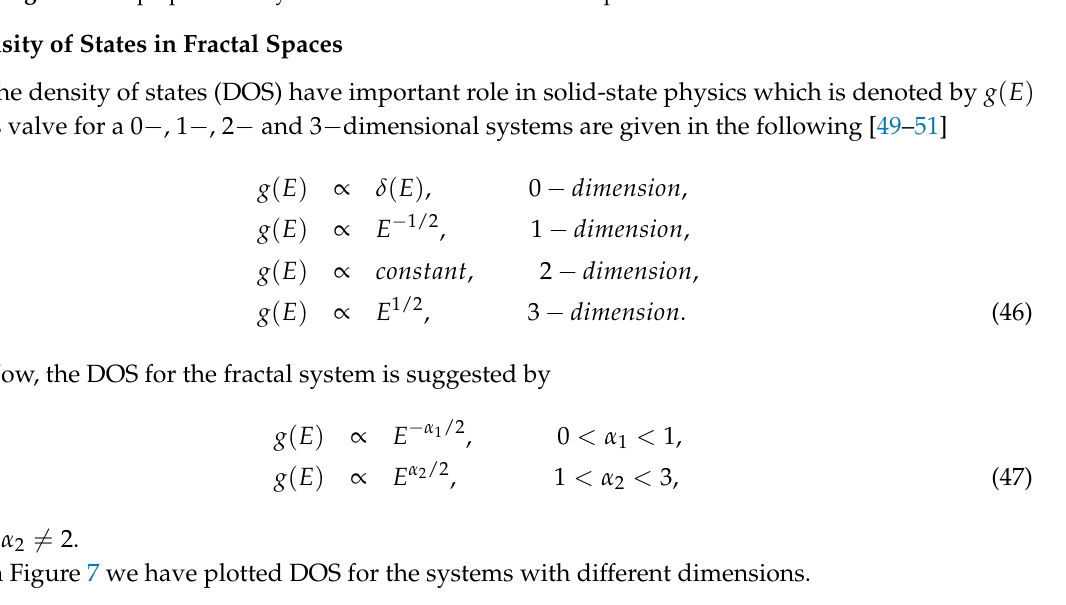
Figure 6. Graph preset Debye solid model for the fractal temperature with different